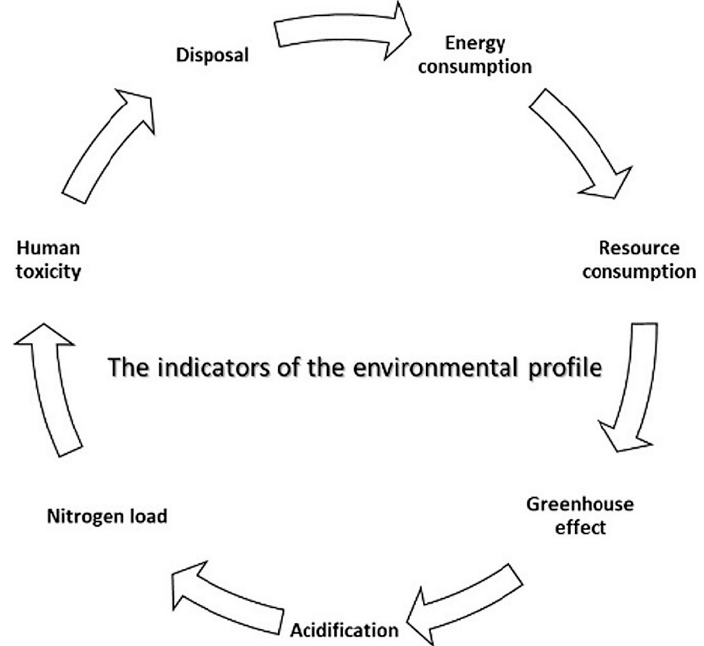
Figure 2. The environmental profile indicators.